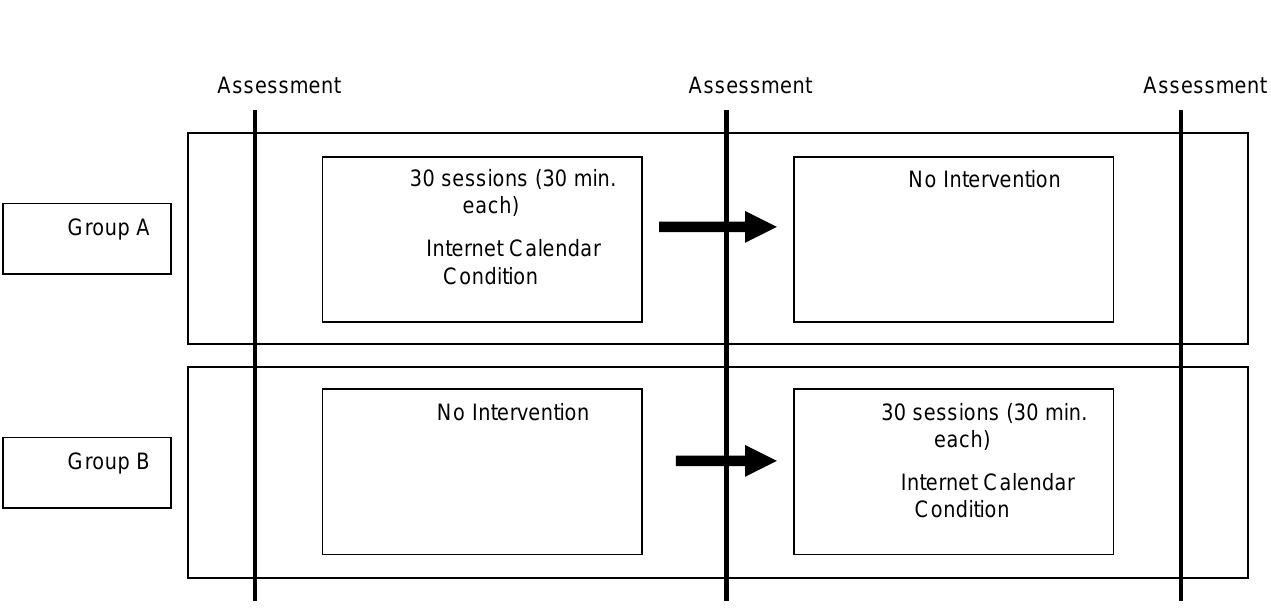
Figure 1. Graphic representation of the study